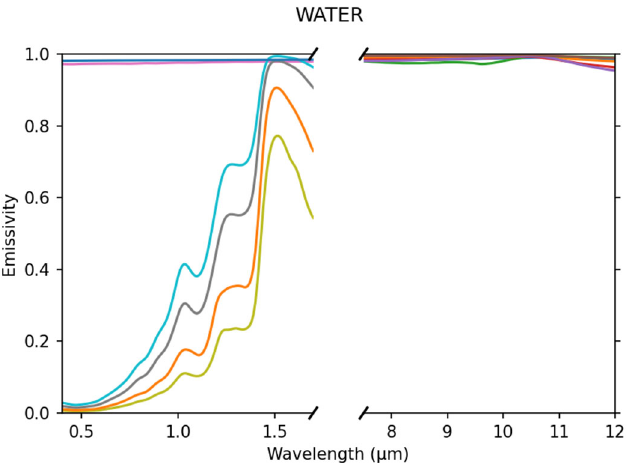
Figure 4. VNIR-SWIR ( left ) and TIR ( right ) Emissivity of the SAIL179 vegetation database.